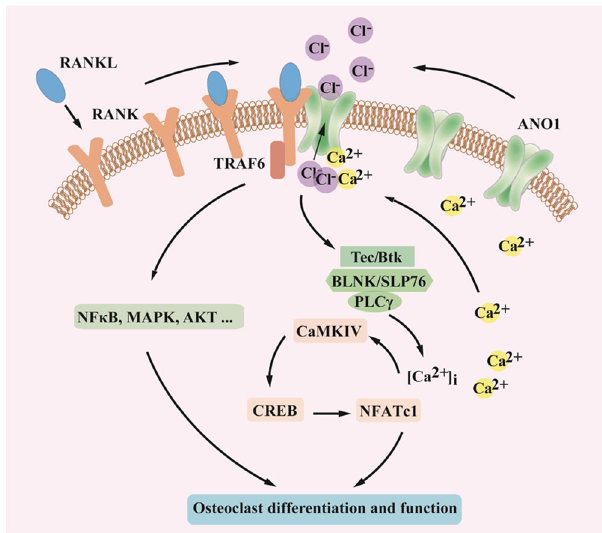
Fig. 7 Schematic model depicting the role of ANO1-mediated osteoclast differentiation and function. Under RANKL stimulation, the interaction between Ano1 and RANK was enhanced, and RANK downstream signaling pathways was activated, which promoted the Ano1 channel activity and enhanced its interaction with